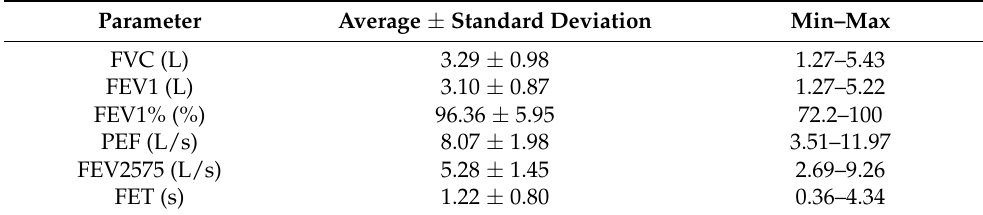
Table 2. Descriptive statistics of the evaluated spirometry